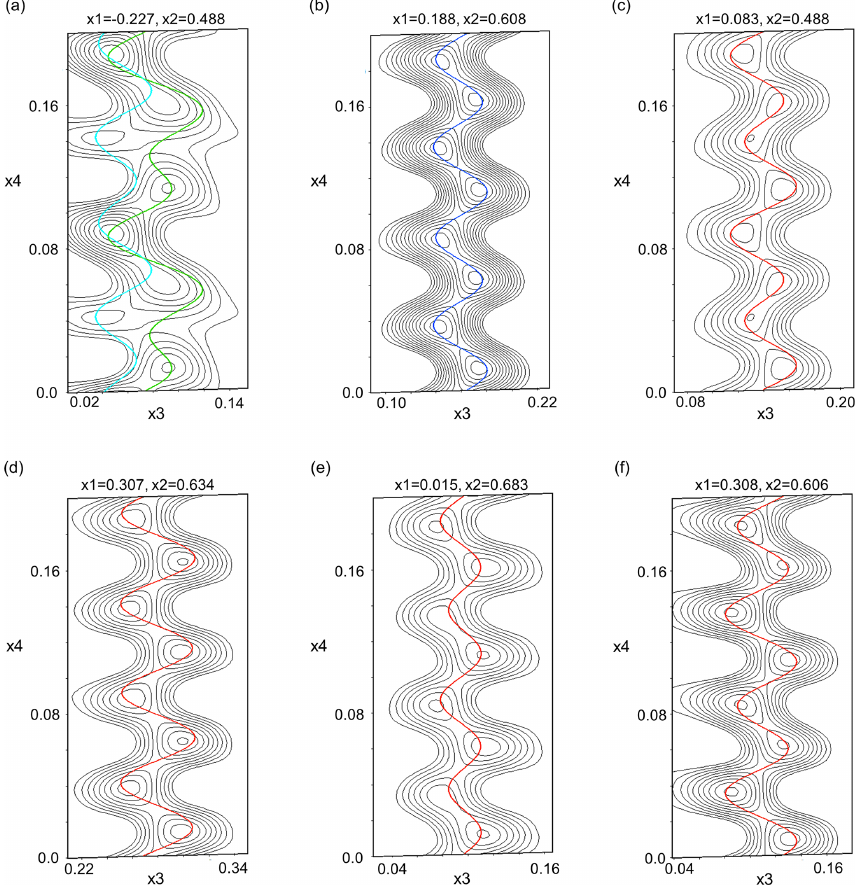
Figure 14. De Wolff sections for (a) both M positions and (b) T2o and its adjacent oxygen: (c) O2, (d) O3, (e) O4 and (f) O7. In the graphs, the position modulation of each atom is plotted over their observed electron potential in the x 4 (modulation direction) versus x 3 ( c axis) plane for a given x 1 ( a axis) and x 2 ( b axis) value. The M2 position is displayed in cyan, M1 in green, T2o in blue and O in